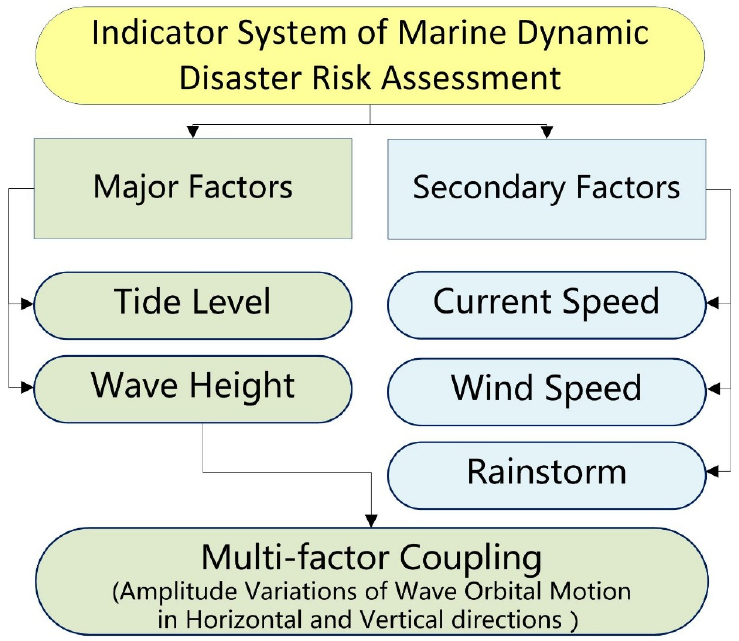
Figure 2. Indicator system for marine dynamic disaster risk assessment.